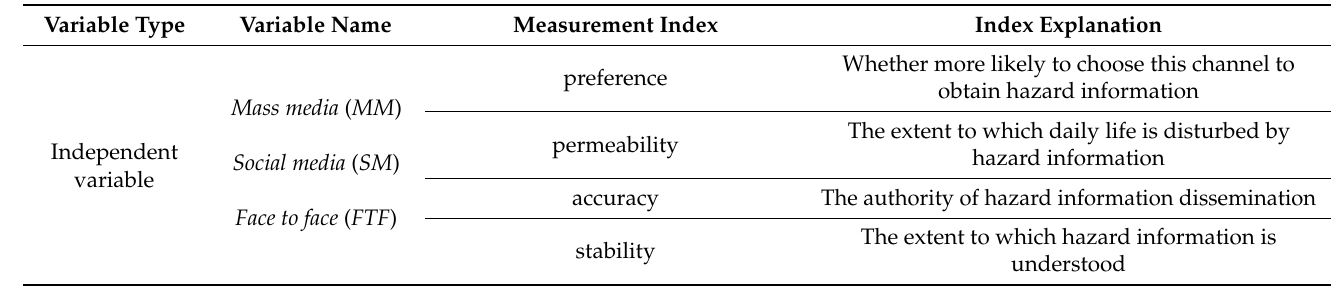
Table 1. Description of